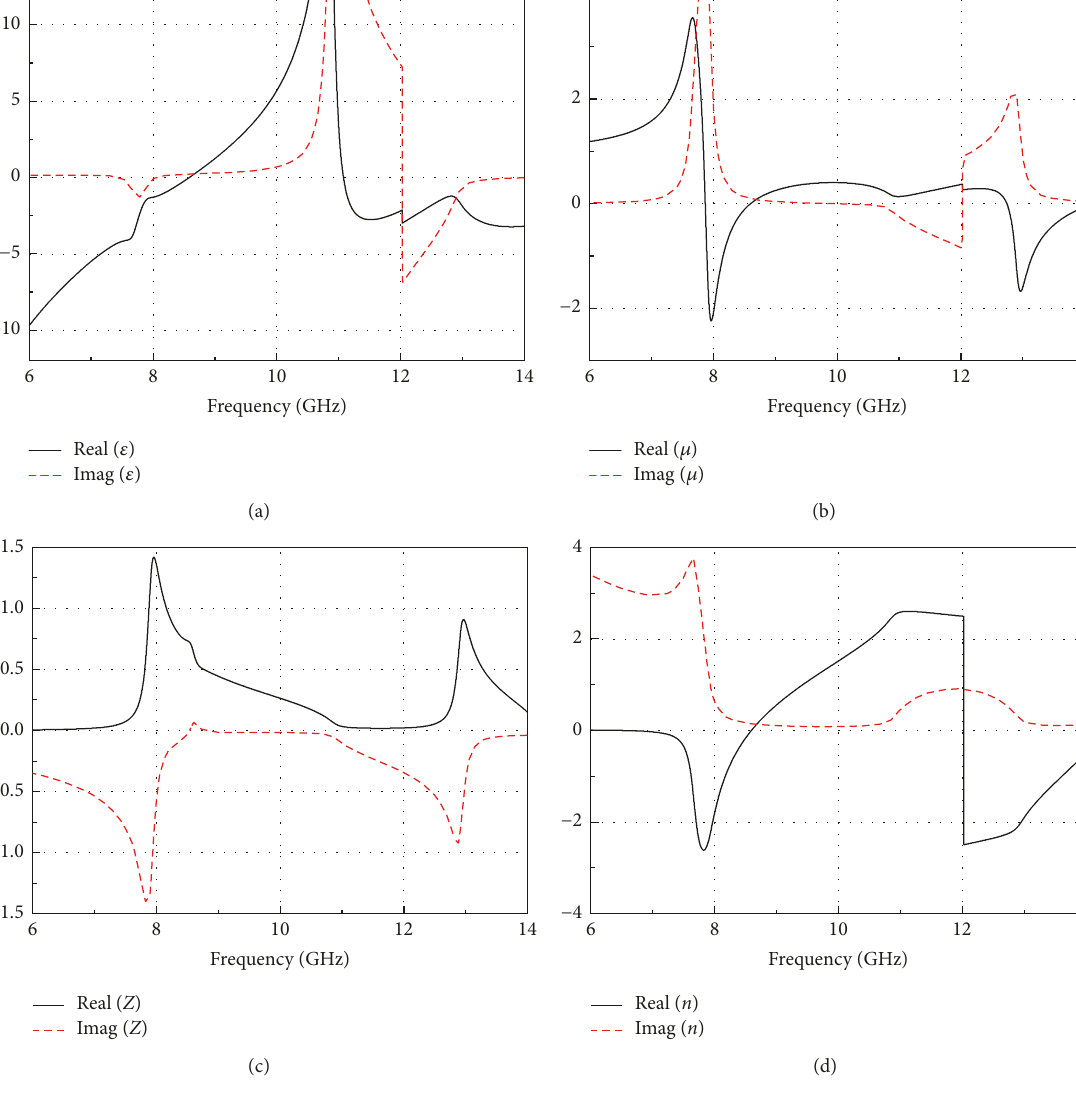
Figure 12: Retrieved effective (a) permittivity “ 𝜀 ,” (b) permeability “ 𝜇 ,” (c) impedance “ 𝑍 ,” and (d) refractive index “ 𝑛 .” The black solid lines refer to the real part of these parameters, while the red dashed lines refer to the imaginary